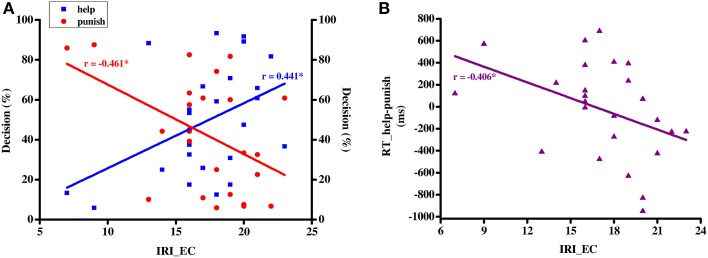
Correlation (A) between IRI_EC scores (X-axis) and average help/punish rate (Y-axis) and (B) between IRI_EC scores (X-axis) and the difference in RT between help and punish (Y-axis). IRI_EC, empathic concern subscale of interpersonal reactivity index scale; RT, response time; *p < 0.05.